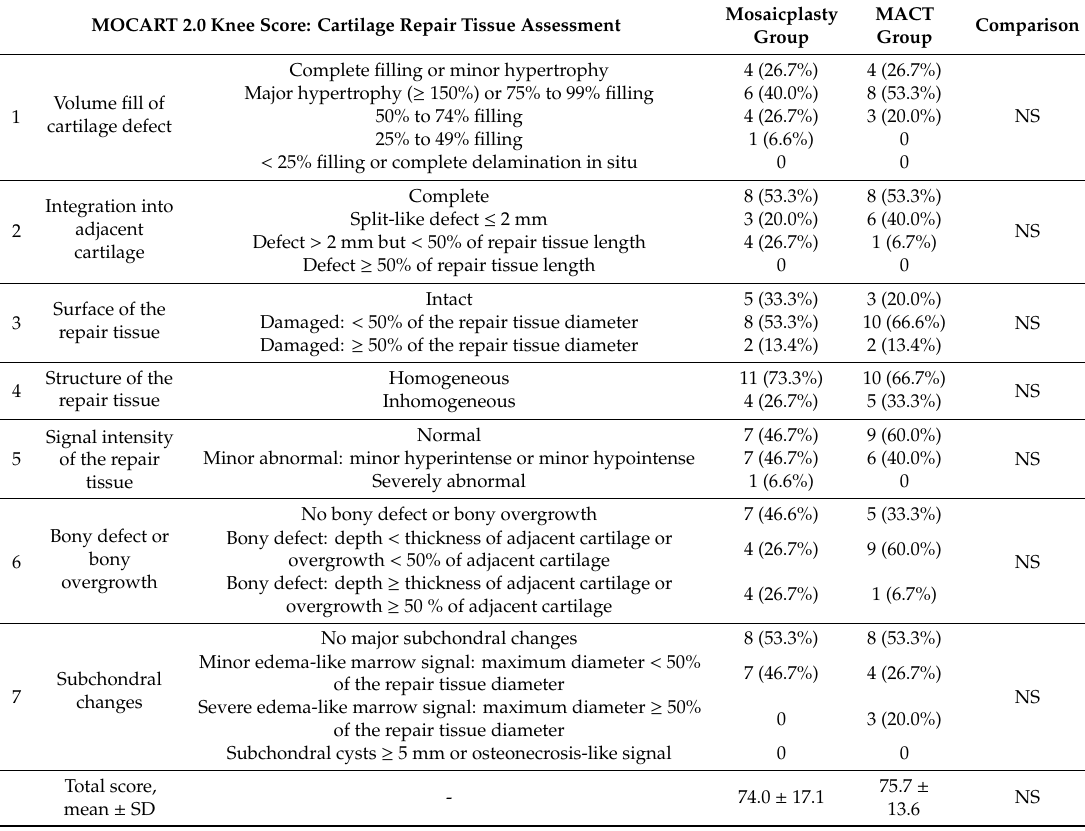
Figure 4. MRI evaluation at 9 years’ follow-up of a medial femoral condyle lesion treated with matrix-assisted autologous chondrocyte transplantation in a 39-year-old woman. Sagittal 3D "Cube" PD ( a ) and coronal PD FAT SAT ( b ) demonstrate a good filling of the defect (arrows) and integration into adjacent cartilage, a homogeneous structure and a normal signal intensity of the repair tissue. Moreover, no significant bony defect, bony overgrowth, or major subchondral changes were detected. Table 2. Magnetic resonance Observation of Cartilage Repair Tissue ( MOCART) 2.0 evaluation.